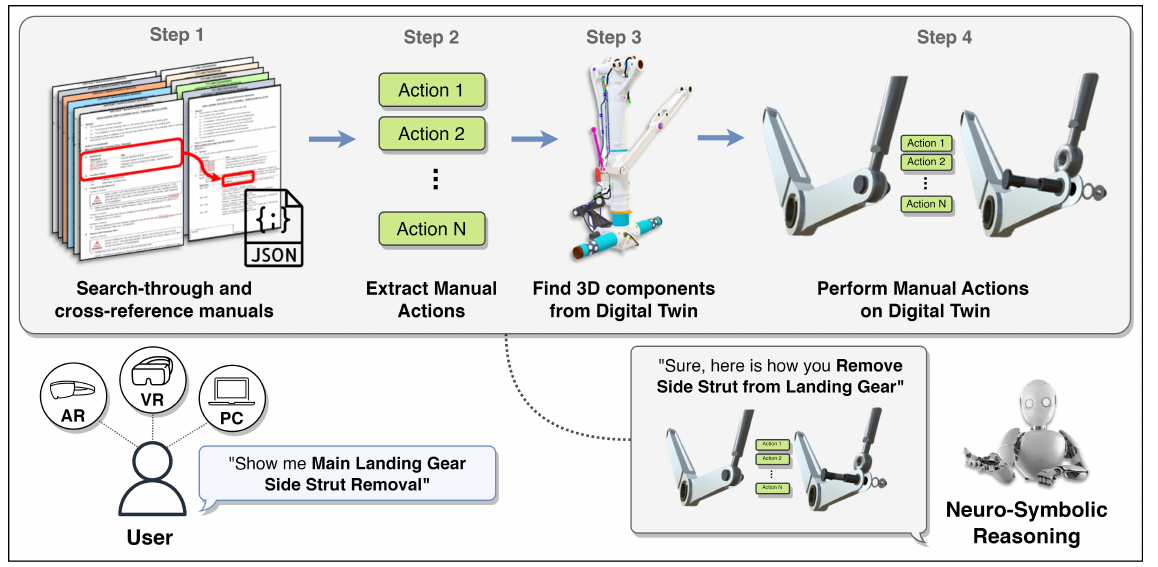
Figure 1. Neuro-symbolic reasoning for interaction with digital twins.